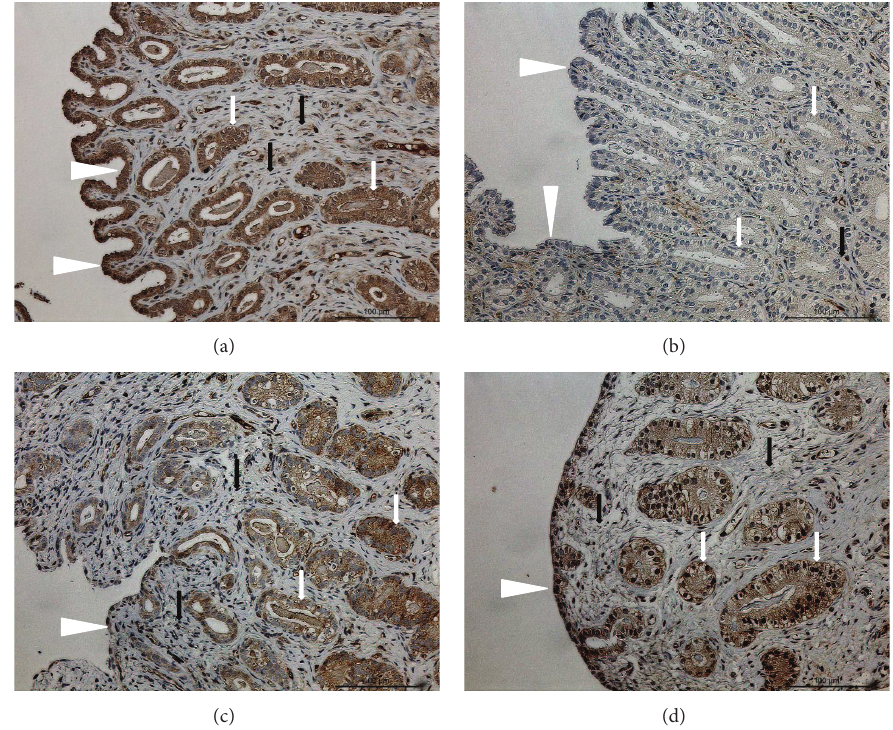
Figure 5: TNF 𝛼 protein localization in endometria. Immunohistochemical (IHC) localization of TNF 𝛼 in the endometria of cats collected at (a) estrus phase (E; 𝑛 = 7 ) and (b) diestrus phase (D, 𝑛 = 8 ) from (c) cats that had been treated with a P 4 derivative analog, medroxyprogesterone acetate (MPA, 𝑛 = 5 ; (d) cats presenting the clinical symptoms of pyometra (PYO, 𝑛 = 3 ). (a) In females at estrus, strong TNF 𝛼 signals are localized in glandular and surface epithelium; (b) in females at diestrus, some weak signals are localized in endometrial stroma; (c) in MPA females, TNF 𝛼 expression is localized mostly in deep glands and weaker signals are present in surface epithelium; (d) in PYO females, signals are mostly localized in both the surface and the glandular epithelium. Surface epithelium: white arrowheads; glandular epithelium: white arrows; endometrial stroma: black